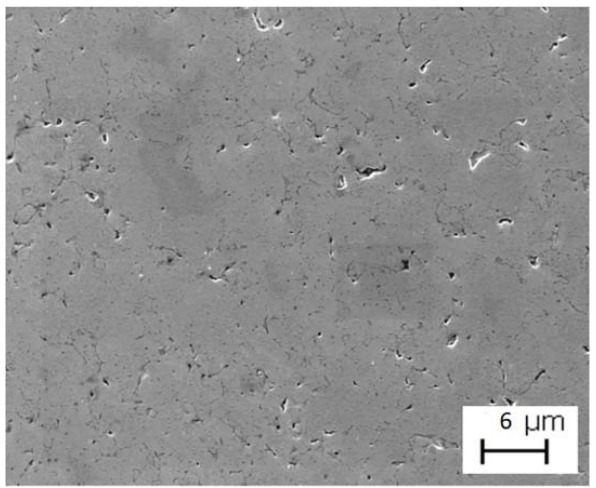
Figure 5. Micrograph of a stainless–steel sintered at 1250 °C for 1 h. Images obtained by SEM. Secondary electron mode. Secondary electron